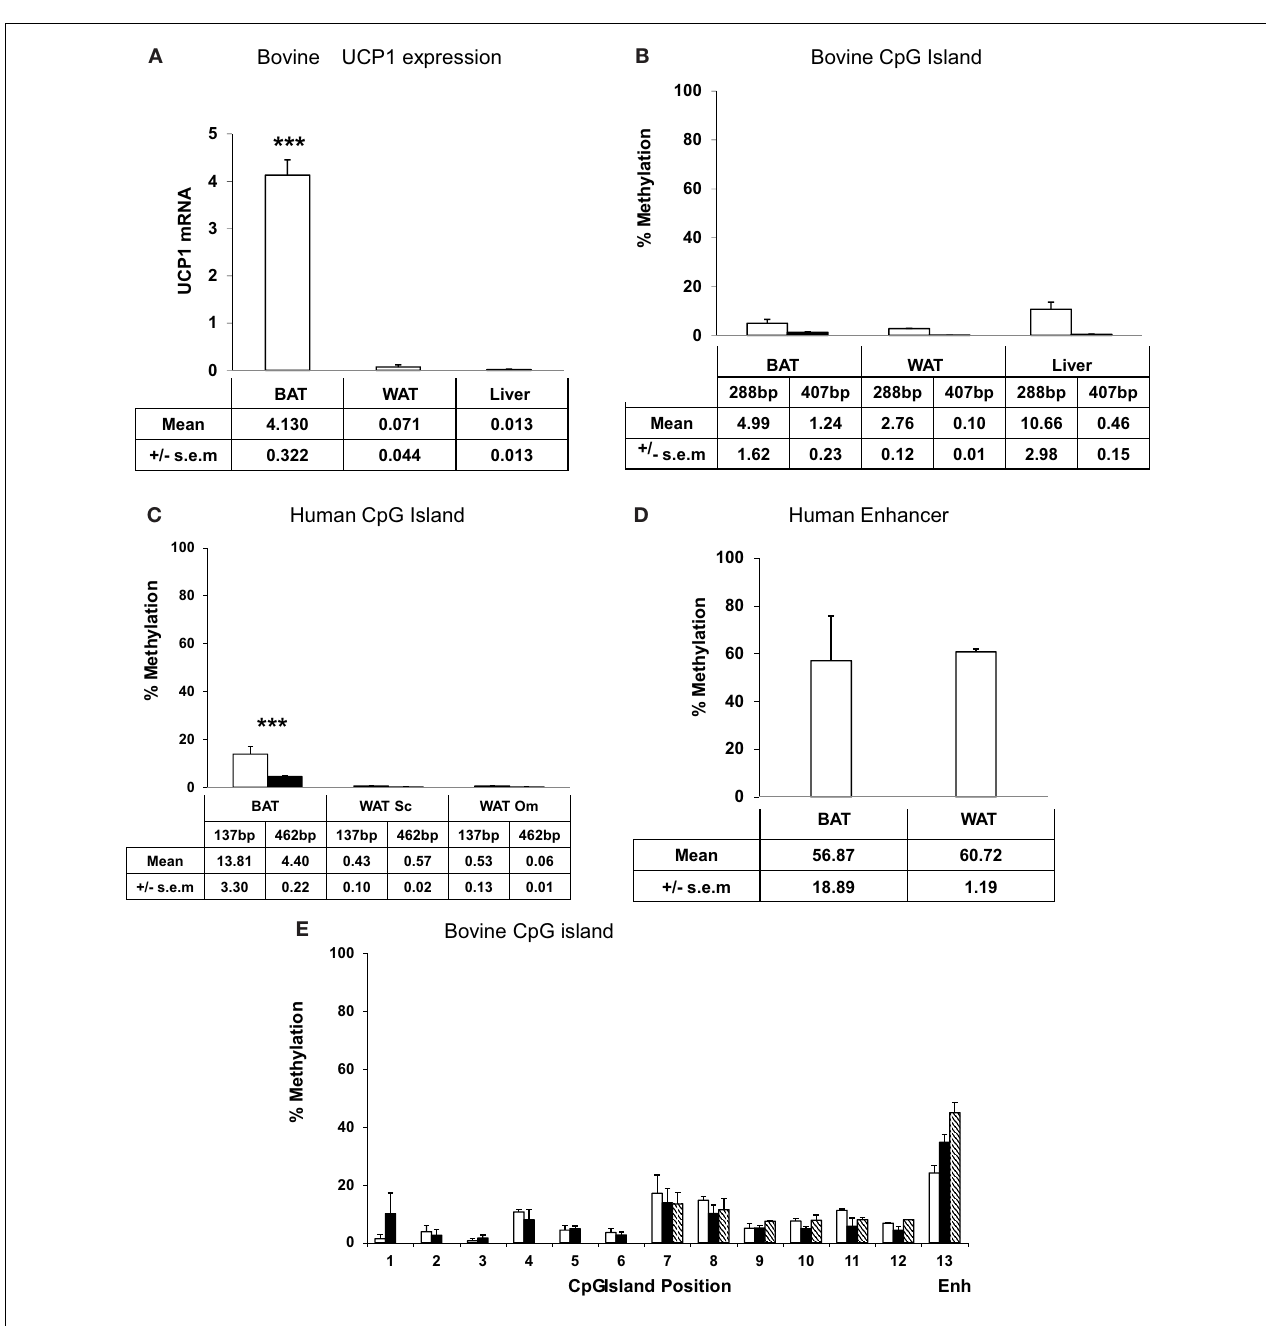
promoter DNA was quantified by qPCR relative to ribosomal 18S DNA. (E) CpG dinucleotide methylation in the Ucp1 proximal promoter in newborn bovine brown ( (cid:3) ) and subcutaneous white adipose tissue ( (cid:4) ), and liver ( ). For comparison, values for the mouse enhancer (ENH) BAT,WAT, and liver are presented. DNA was extracted, bisulfite modified, amplified by PCR, and pyrosequenced to determine CpG methylation over positions 1–12 of the Ucp1 promoter (see Materials and Methods). Missing liver values are due to failed analyses.Values are means ± SEM from at least three replicates except for (D) which represents the average of duplicates ± SD *** BAT significantly greater than other tissues ( p <